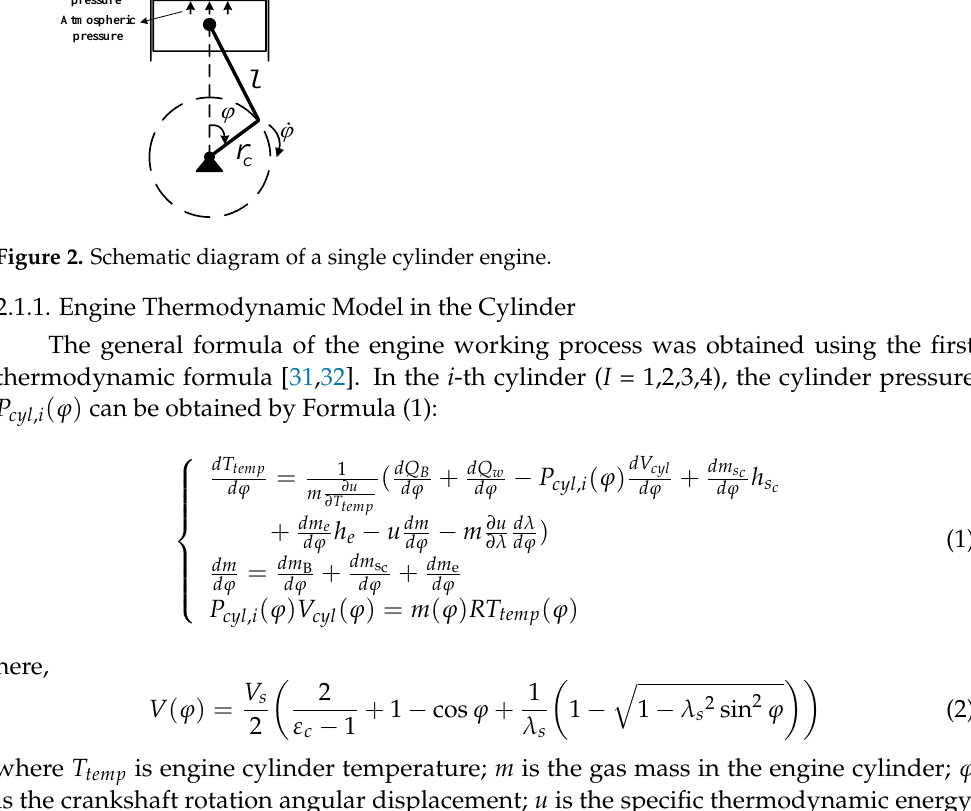
Figure 1. Structure diagram of the compound PS-PHEV.